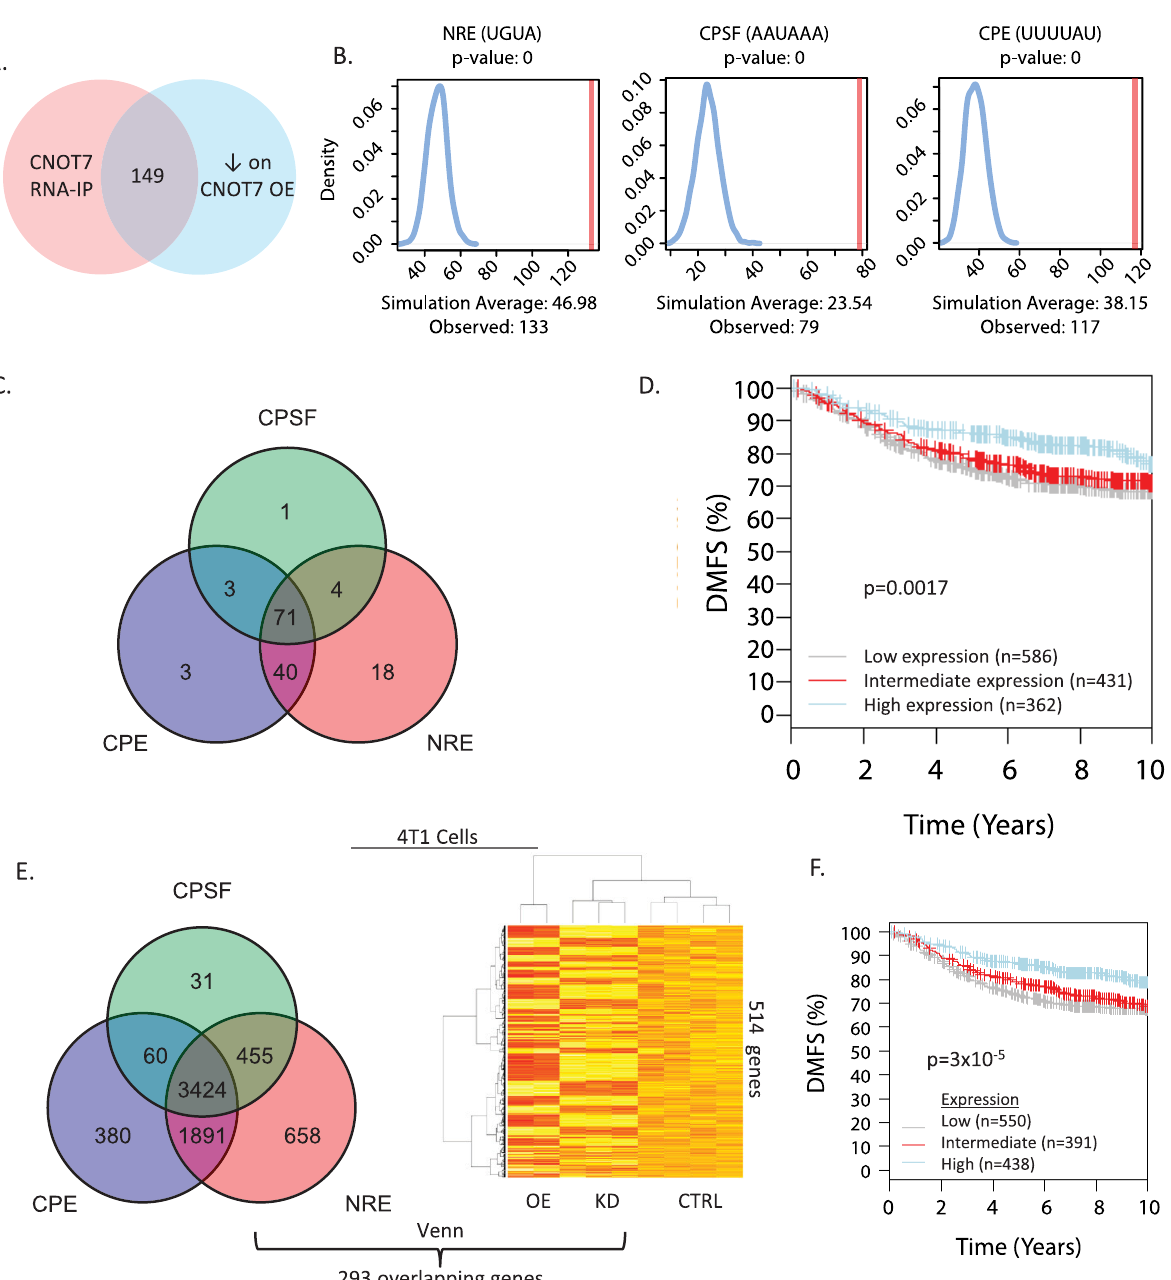
Fig 8. Overlap between transcripts identified by RNA immunoprecipitation (RNA-IP) and the microarray analyses (A). RNA binding protein motif enrichment for the RIP-seq transcripts (B). Overlap analysis of the CPE, CPSF and NRE RNA binding protein motifs in the 149 transcripts in common between the RIP-seq and microarray experiment (C). Kaplan-Meier analysis of the GOBO meta-dataset using as a weighted gene signature the 46 represented human orthologs of the 71 tripartite motif-possessing transcripts detected by RIP-seq (D). Results of genome-wide analysis of transcripts containing predicted CPE, CPSF and NRE RNA protein binding motifs (E). Overlap of this gene set with the Cnot7 inversely correlated genes from the microarray analysis identified 293 genes in common. Kaplan-Meier analysis of GOBO meta-dataset using the 293 CPE/CPSF/NRE tripartite transcripts as a weighted gene signature